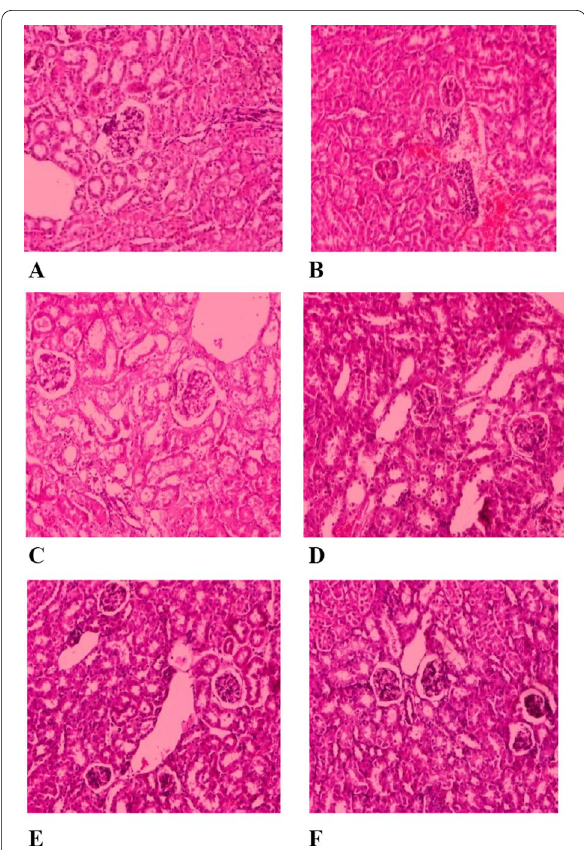
Fig. 17 Hematoxylin and eosin-stained sections of mice kidneys. a Glomeruli of normal control mice. b Glomerular thickening of diabetic mice ( c – e ). Glomeruli of diabetic mice treated with c 100 mg/kg and d 200 mg/kg e 300 mg/kg per day MELCF which reduced the development of STZ-induced alterations in the kidney. (F) Gromeruli of metformin 200 mg/kg treated